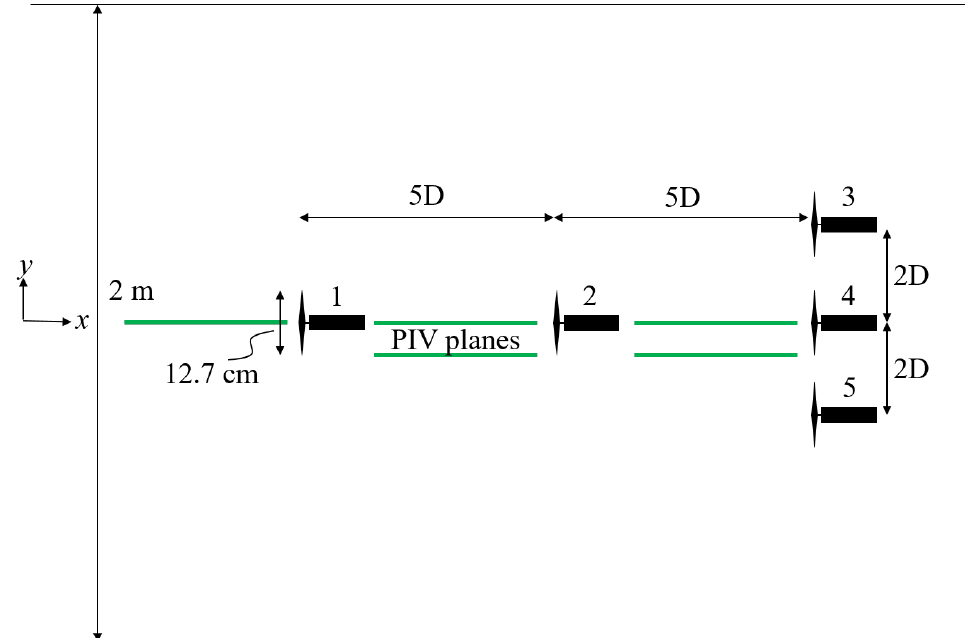
Figure 8. Plan view of the test section showing turbine arrangement and the placement of PIV planes.